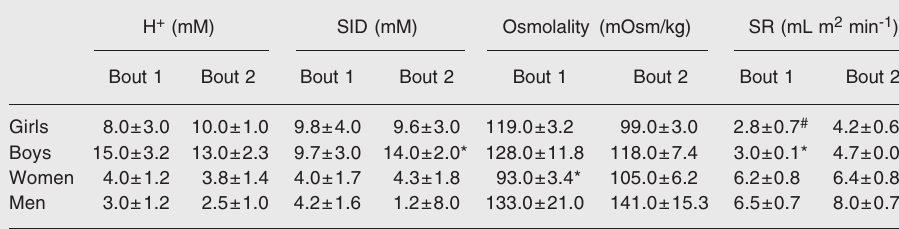
Data are reported as mean ± SEM.